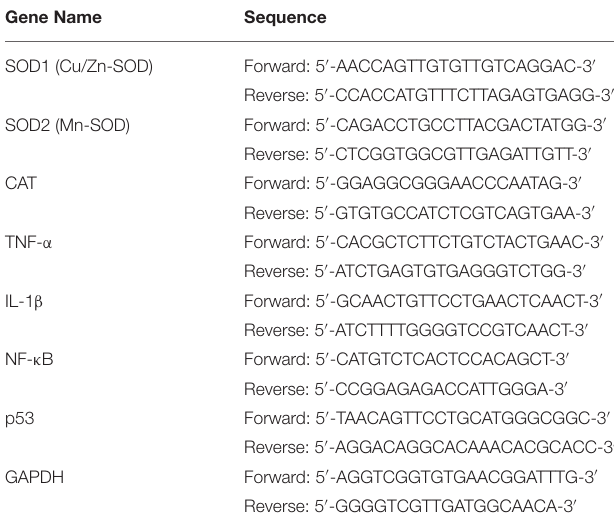
TABLE 1 | Primer sequences of quantitative polymerase chain reaction (qPCR) for this